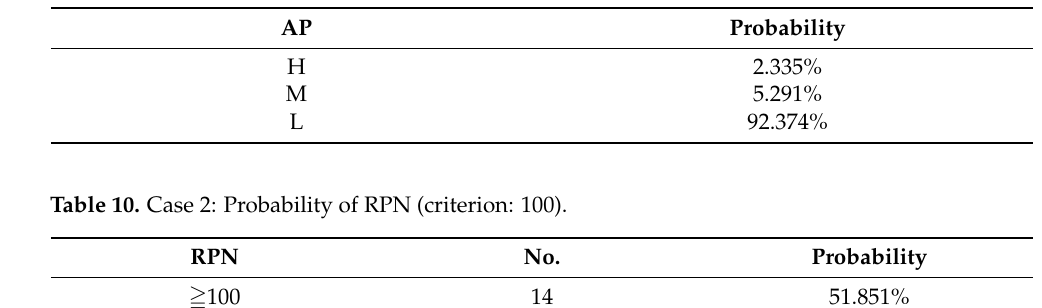
Table 9. Case 2: Probability of AP.